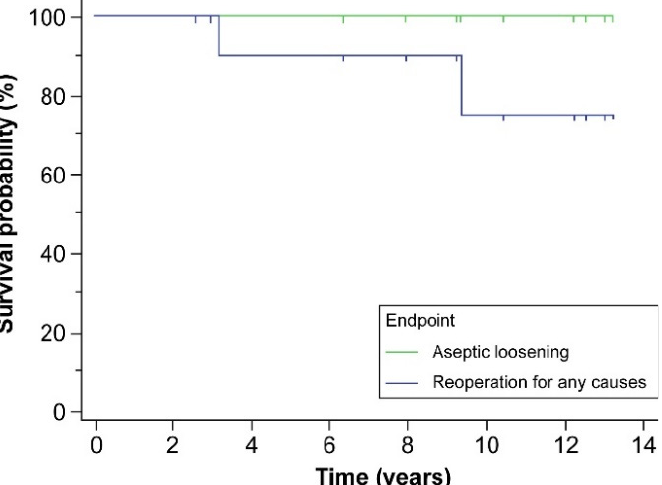
Figure 4. The Kaplan–Meier survivorship was 100% with aseptic loosening as the endpoint, and 90% and 75% at five- and ten years, respectively, with reoperation for any reason as the endpoint.